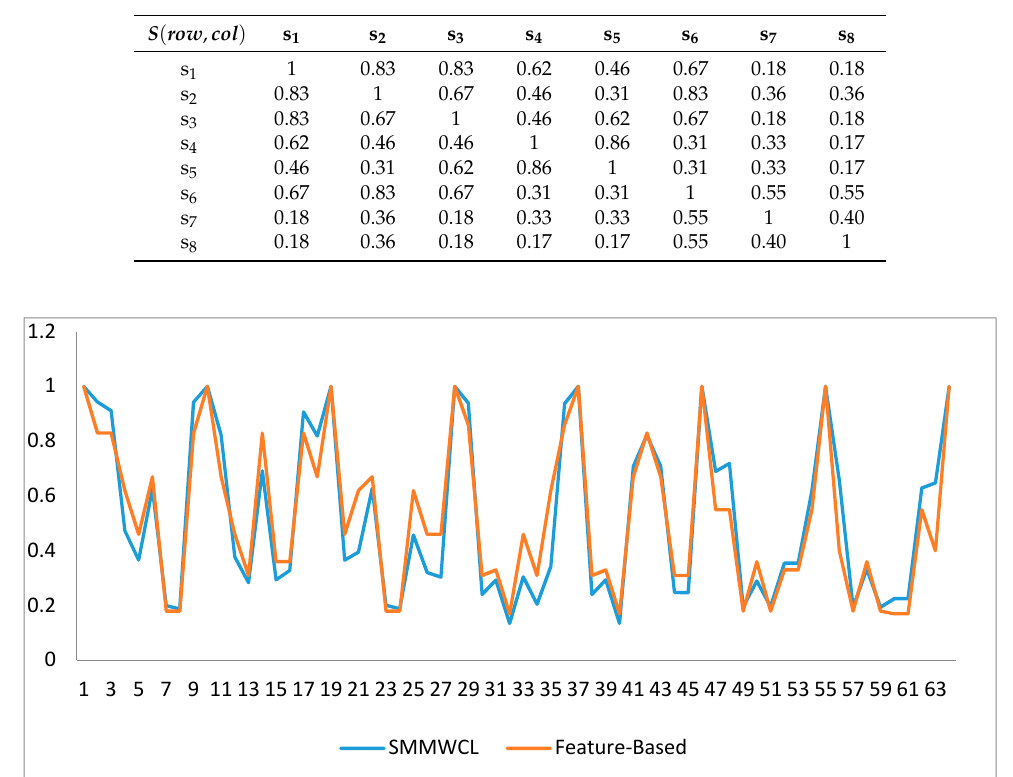
Table 8. Semantic similarity table (feature-based approach).